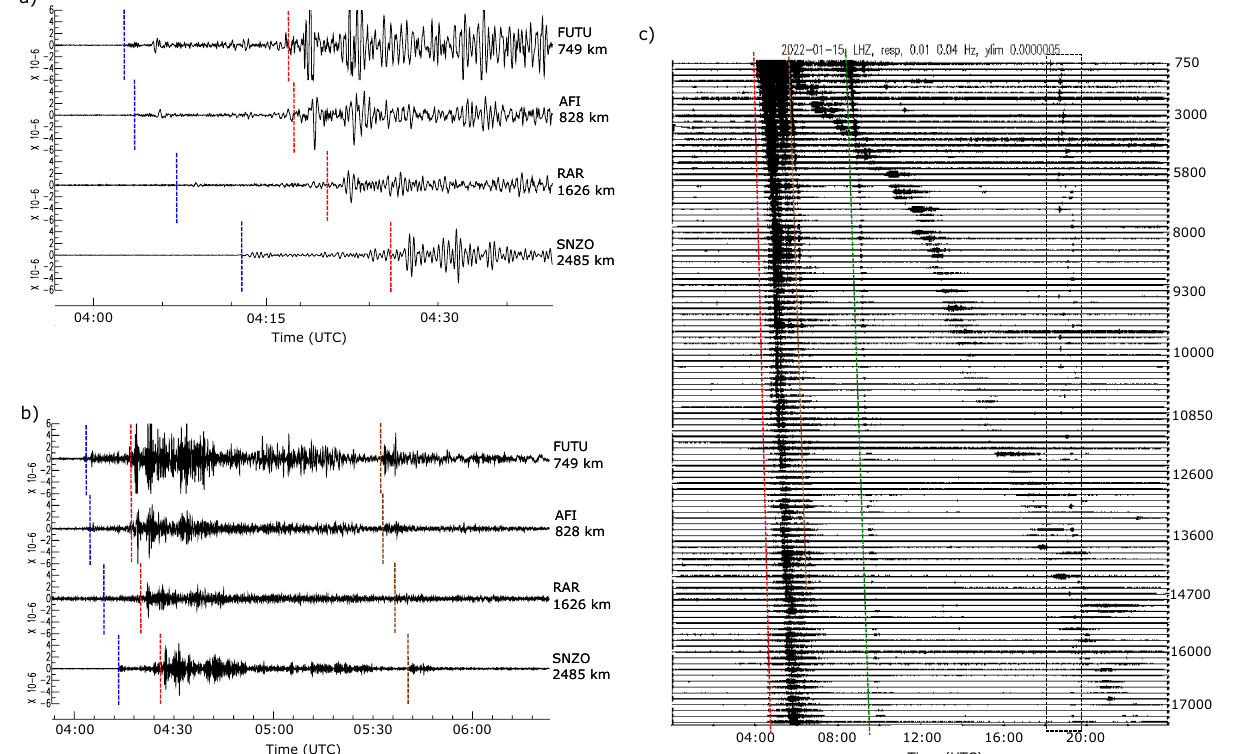
Fig. 1 Seismic records of the Hunga-Tonga eruption. Instrumental response has been removed, data have been fi ltered between 0.01 and 0.04 Hz and plotted without amplitude normalization. The amplitudes of the signals are expressed in m/s and the traces are ordered according to their epicentral distance. a Detail of the signal onset at the closest stations. Red dashed line shows the most energetic arrival, compatible with the origin time in seismic catalogues. Blue dashed line shows the fi rst arrival observed in the fi ltered data. The labels indicate the name of the station and the distance to the origin. b Larger-scale scale view of the same dataset, showing the arrival from a second event detected around 05:30 (brown dashed lines). c Seismic traces for the entire dataset during January 15, 2022. Red line shows the main arrival, brown line the phases related to the 05:30 event and green line those related to the event detected around 08:25. The black box shows the arrivals from a 5.7 magnitude earthquake with epicentre in the Paci fi c-Indian Ridge. The signal observed in intermediate times propagating with slow apparent velocity, corresponds to the atmospheric wave and will be discussed in the following section. Labels on the right side show the approximate epicentral distance, expressed in